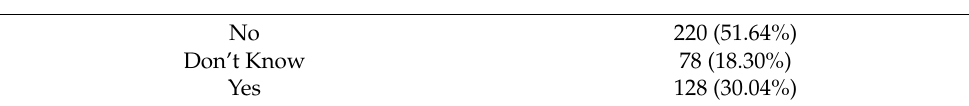
Table 3. Respondents’ opinions regarding vaccine protection against new variant strains.